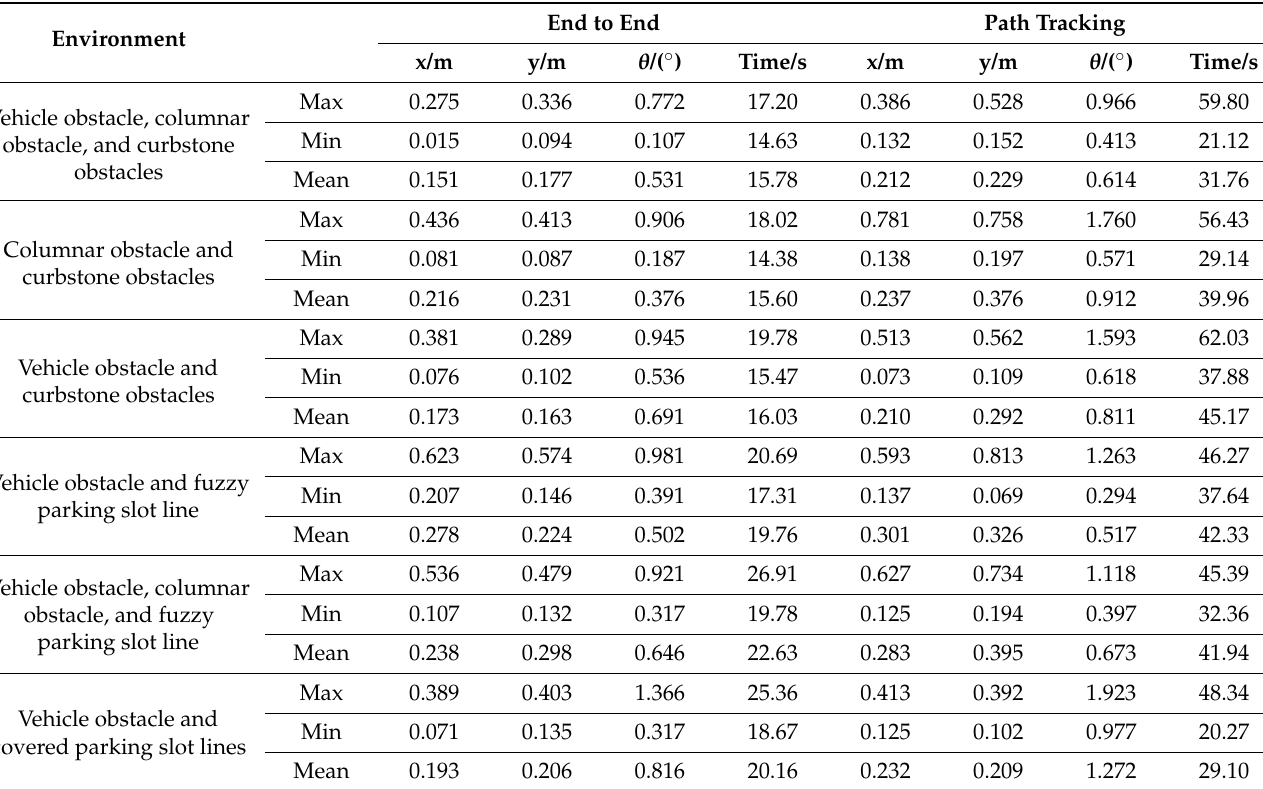
Table 5. Intelligent parking average comparison